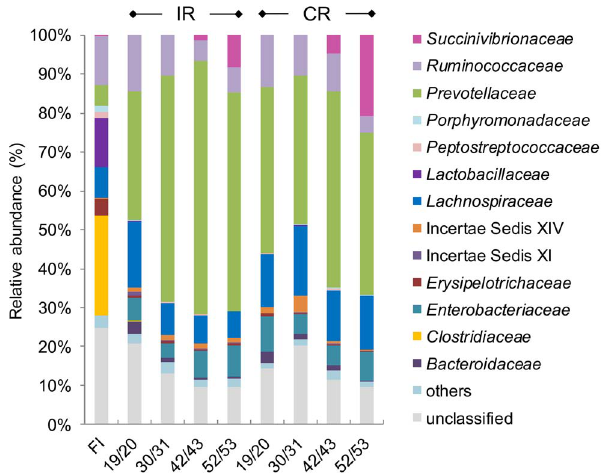
Figure 3. Microbial composition in the fecal inoculum (FI), IR and CR measured by 454 pyrosequencing. The relative abun- dance on family level is shown. Values , 1% are summarized in the group